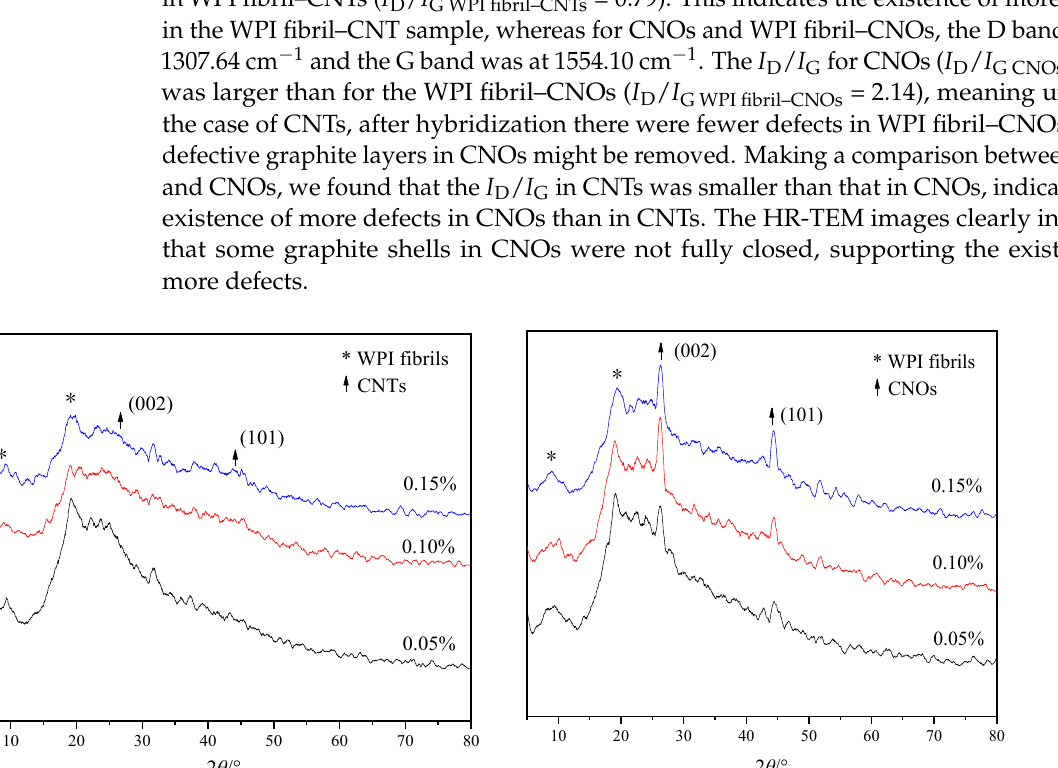
11 of 16 Figure 5. FTIR of WPI fibril–CNTs (or CNOs) (the concentrations of CNTs or CNOs were 0.05 wt.%, 0.1 wt.%, and 0.15 wt.%): ( a ) WPI fibril–CNTs; ( b ) WPI fibril–CNOs. In Figure 5a, the absorption peaks did not change significantly with the increase in the amount of CNTs. This suggests that the increase of CNTs did not significantly compound more WPI fibrils, implying that the interaction between WPI fibrils and CNTs was weak. In Figure 5b, however, the intensity of absorption peaks increased with the increase of CNOs, indicating that more CNOs would compound more WPI fibrils. The characteristic peaks of FTIR spectra could be used to analyze not only the functional groups of the composites, but also the secondary structures of the proteins. It